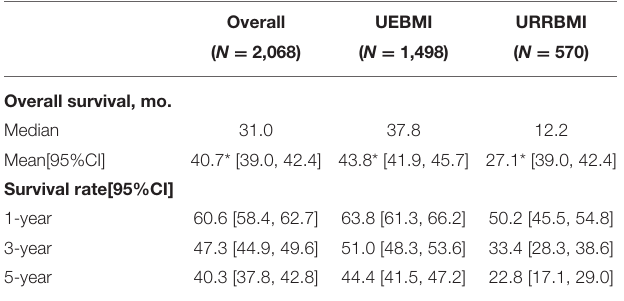
Overall survival, mo.